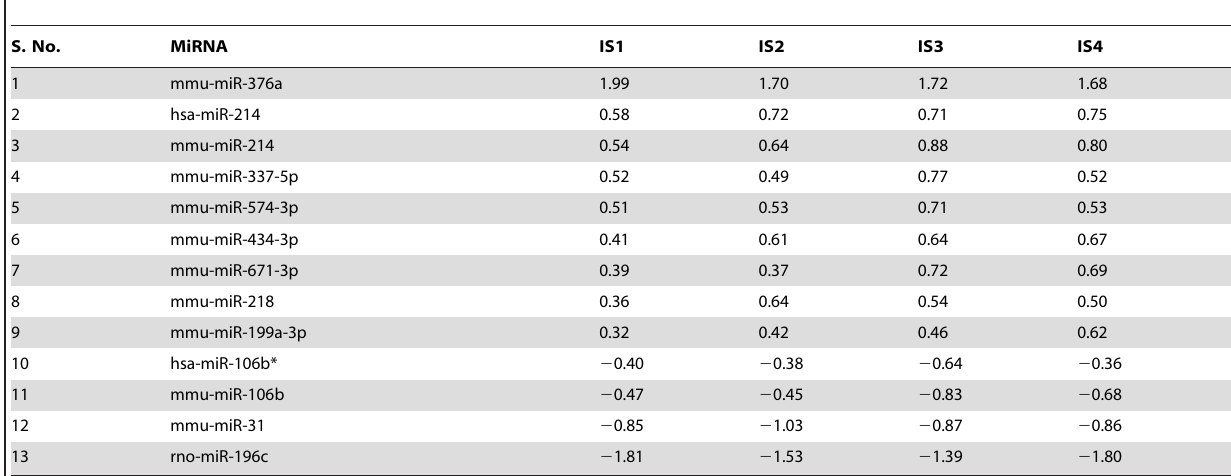
Table 5. Common MiRNA among all injury groups.